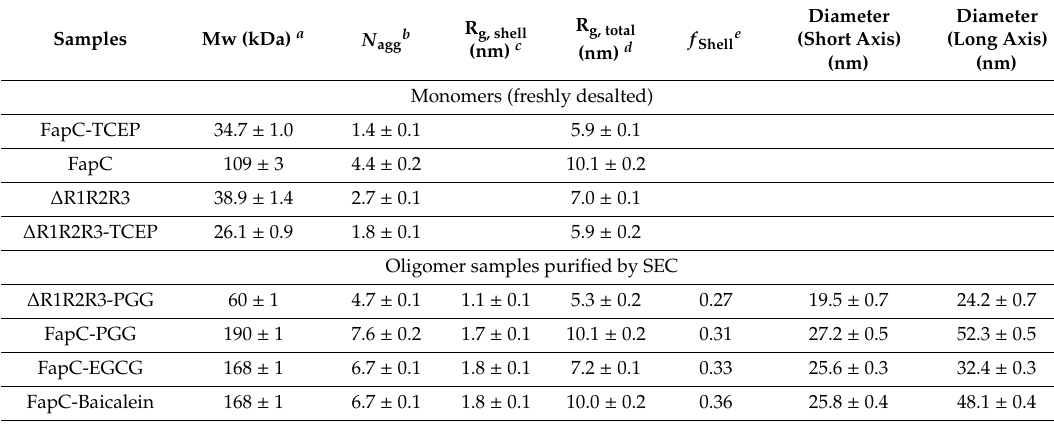
Figure 7. SEC- and SDS-PAGE-based analysis of FapC oligomers formed in the presence of polyphenols. ( A ) After 1 h incubation, samples were separated by SEC and the indicated oligomer fractions pooled and run on SDS-PAGE; ( B – D ) time course of oligomer formation: SEC profiles over time of FapC incubated with ( B ) PGG, ( C ) oleuropein, and ( D ) without inhibitor. Table 1. SAXS data for monomers and SEC-purified oligomers of